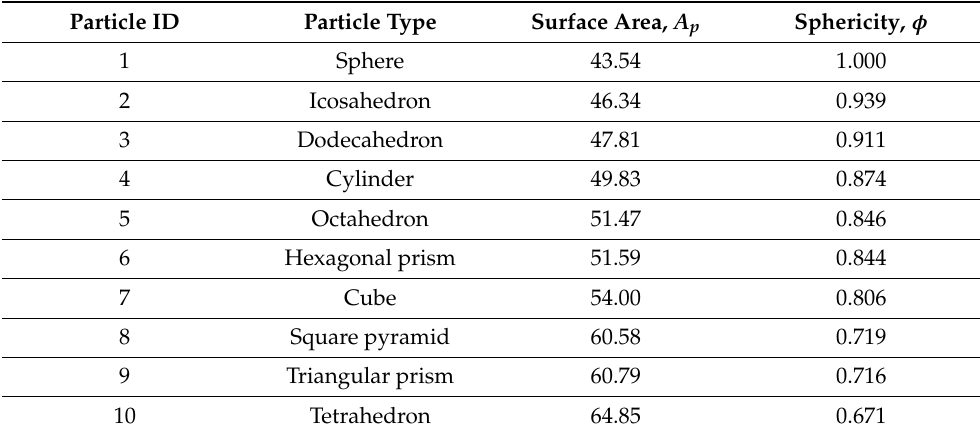
Table 1. Overview of sphericity and surface area of all particles together with assigned particle ID ( A in mm 2 ). p